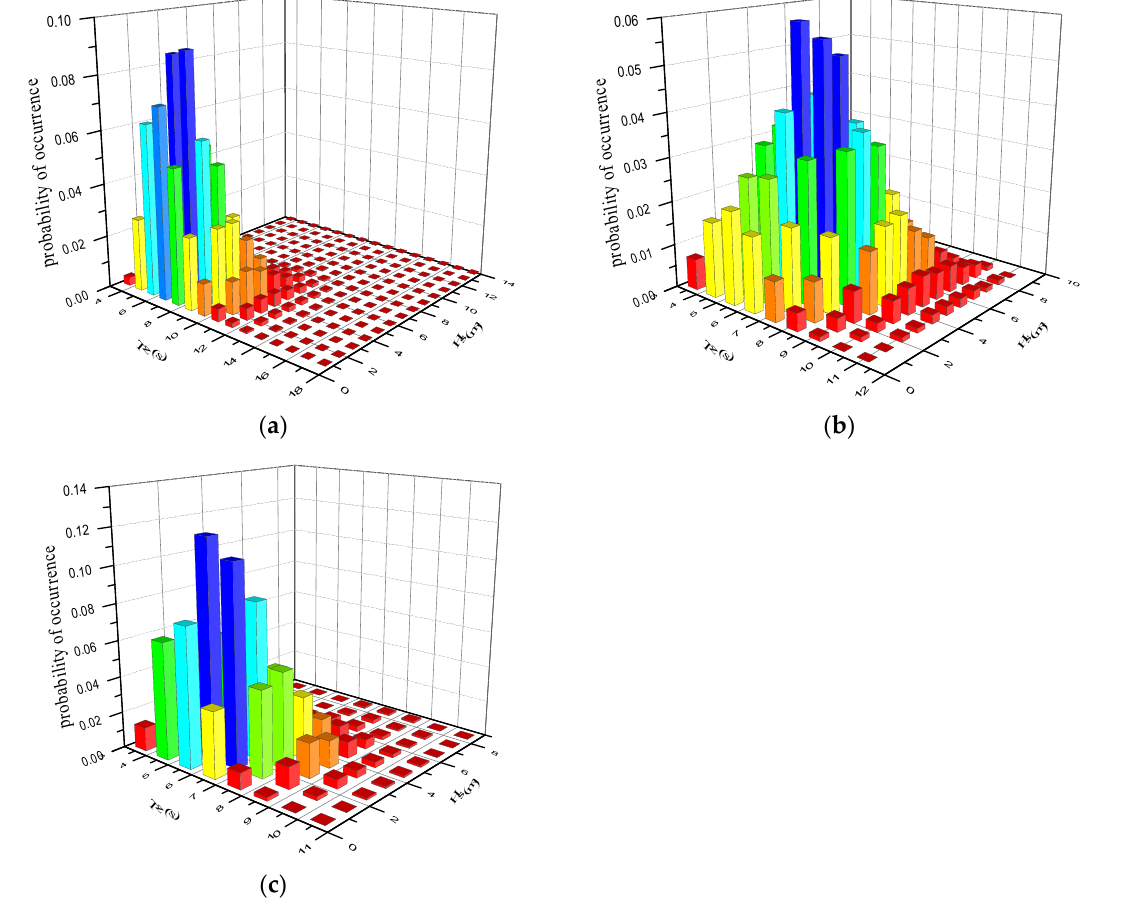
Figure 9. Wave scatter diagrams as follows: ( a ) World Wide Trade, ( b ) Northwest Pacific, and ( c ) China Coast.